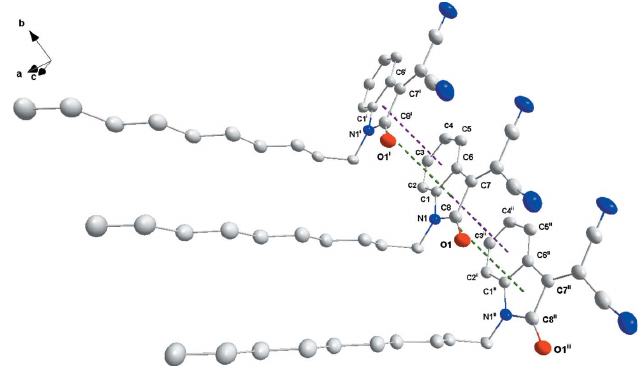
Figure 3 Detail of the offset (cid:2) – (cid:2) -stacking (purple dotted lines) and